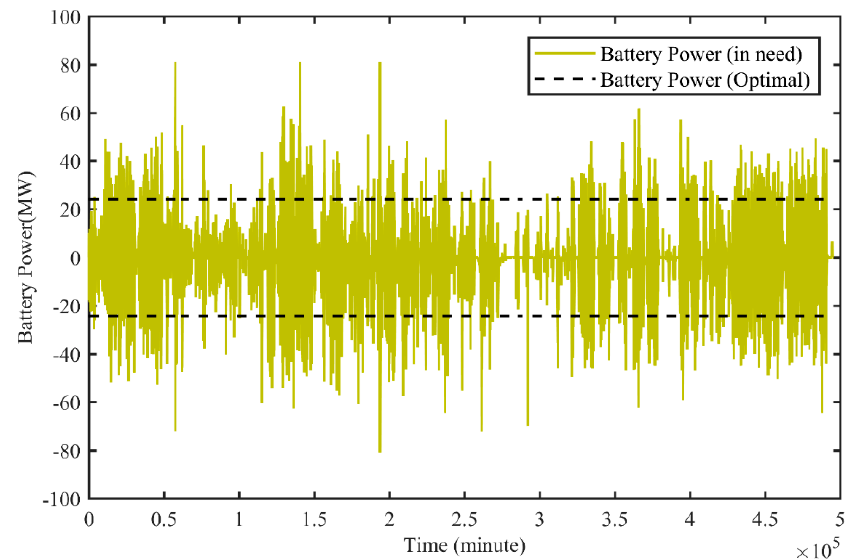
Figure 7. Plot of minute-to-minute BESS requirement and optimal BESS power.